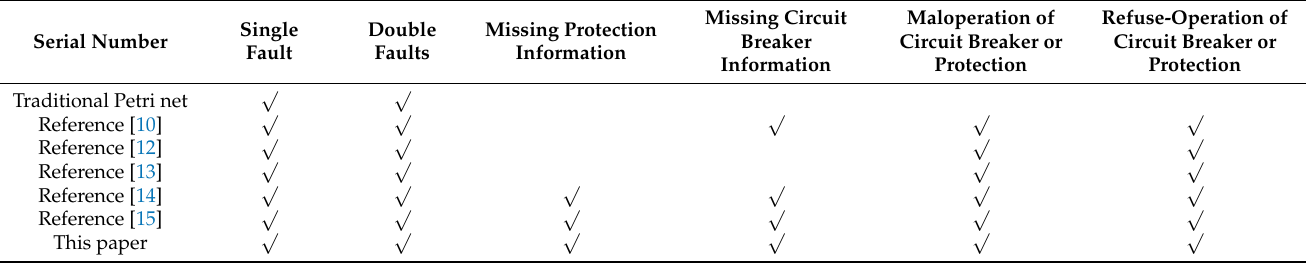
Table 9. Comparison of characteristics among different fault diagnosis